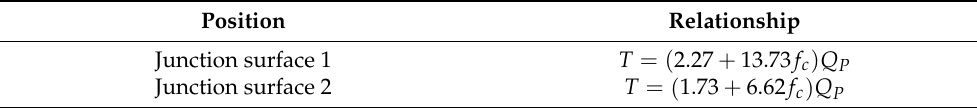
Table 2. Relationship between preload torque and preload force. Position